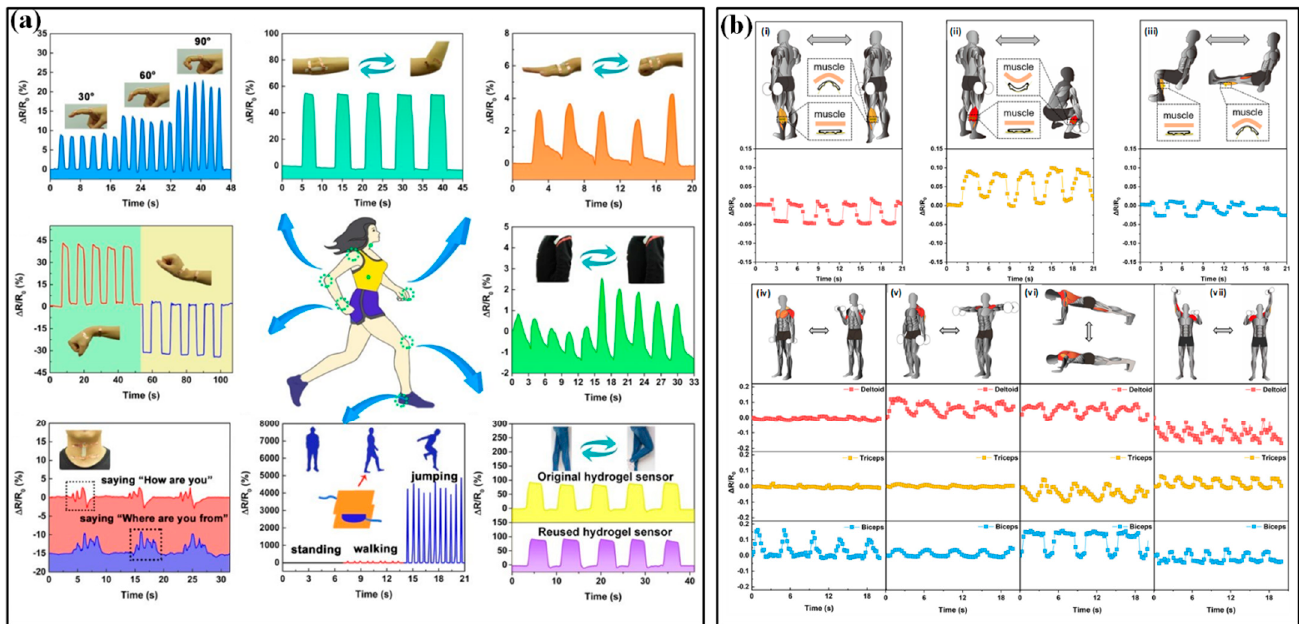
Figure 6. The applications of strain sensors in sport monitoring: ( a ) monitoring the joint bending of different parts of body [92]; ( b ) monitoring the muscle contractions during extensions of standing heel lifts (i), squats (ii) and leg (iii) and the state of biceps, triceps and deltoid during standing dumbbell curls (iv), side lateral raise (v), push-ups (vi), and shoulder press (vii) [93] . Reproduced with permissions from The Royal Society of Chemistry (2020)[92].